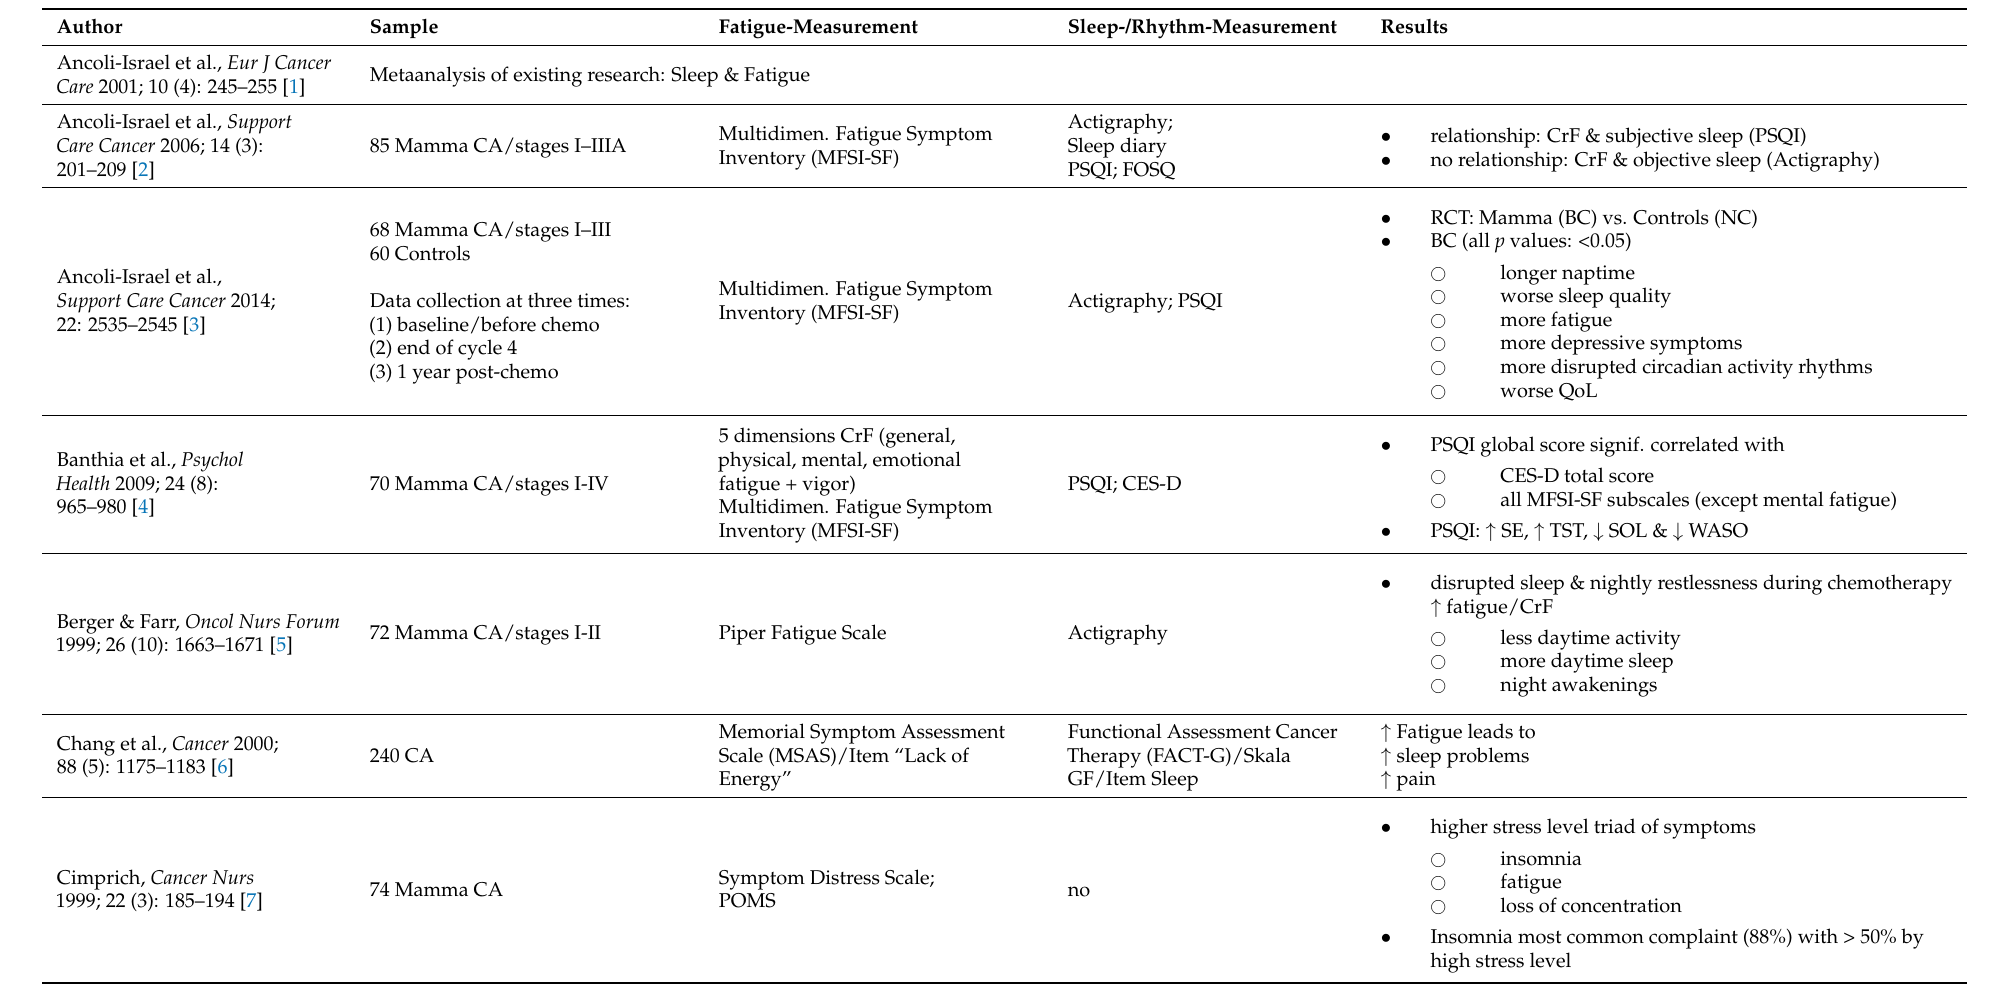
Table 2. Studies on Sleep and Cancer-related Fatigue (CrF) in cancer/ Connection between sleep and fatigue in oncological diseases